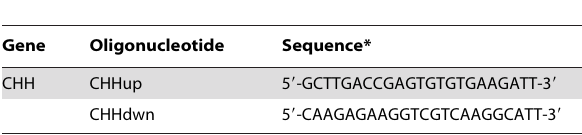
Table 1. Oligonucleotide